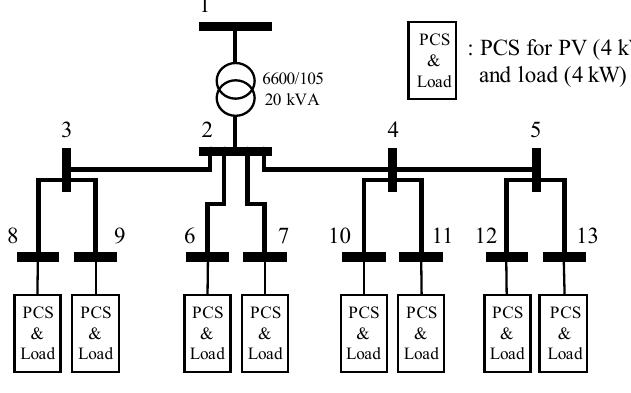
Figure 6. LV distribution system model. Table 2. Impedance of LV distribution system model.